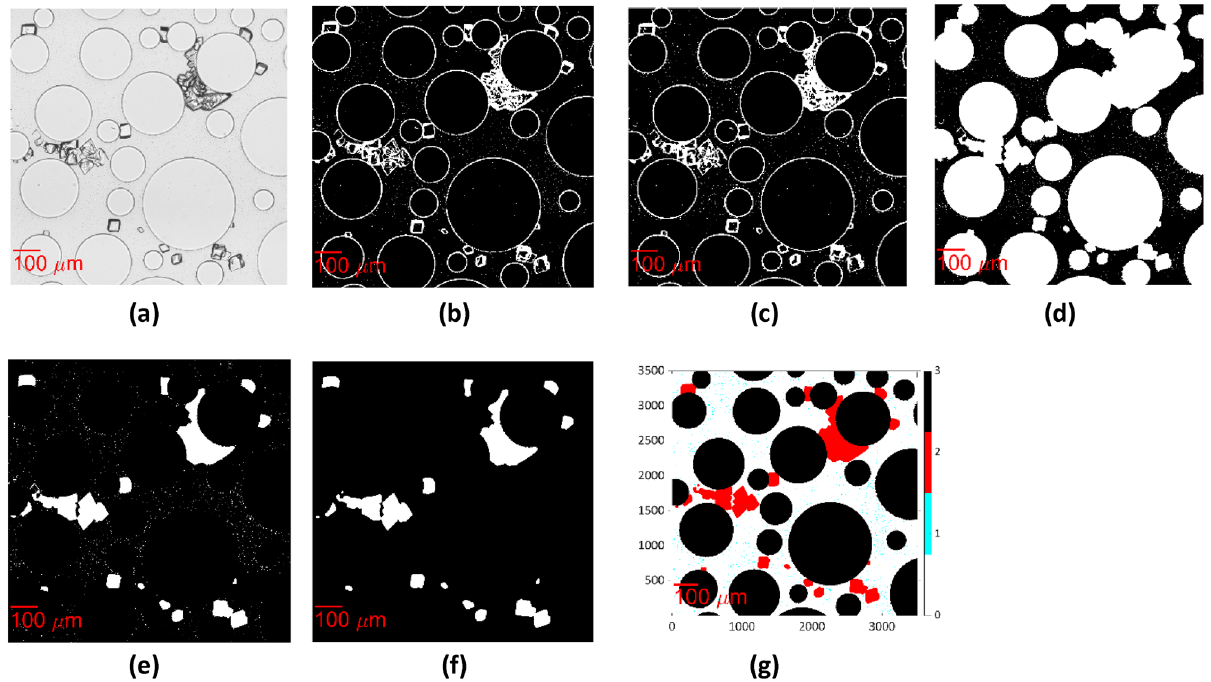
Figure 5. Workflow presenting the extraction of the binary image of crystals from the brightfield image at t = 10 h ( a ) Section of dimensions 1.022 mm × 1.022 mm of the raw image of the green channel; ( b ) Image binarization, ( c ) "Imclose" MATLAB function to smooth the edges of the outlines of crystals and close any existing holes, ( d ) “imfill” function to fill the crystals and the pillars with white ( e ) Set the pixels that correspond to the pillars in Fig. 3d to black, ( f ) Final result of the crystal segmentation ( g ) Final result of the image processing algorithm segmenting pore fluid (white), solid grains (black), and bacteria (cyan) at t = 10